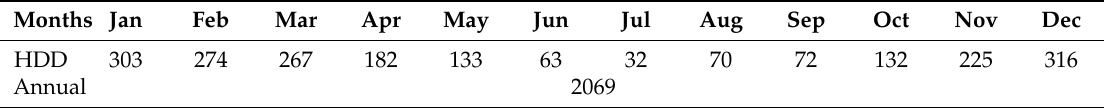
Table 3. Heating degree days (HDD) for